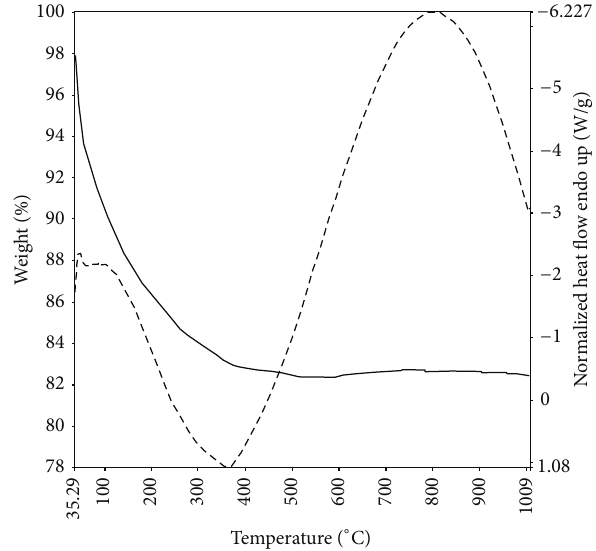
Figure 3: TGA/DTA curve of iron oxide heated at 70 ∘